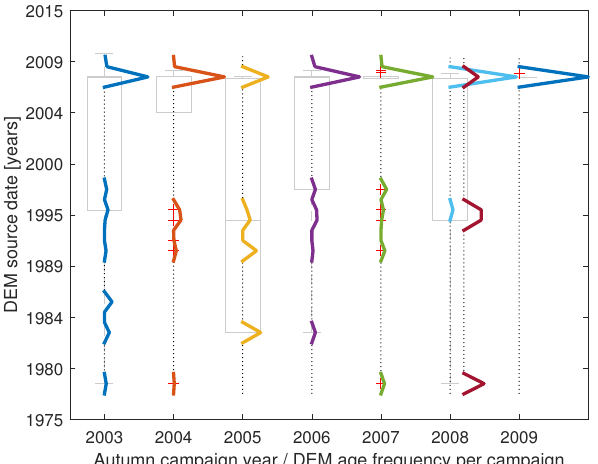
Figure 5. DEM source date distributions for ICESat autumn cam- paign samples on glaciers. The box plots emphasize the average DEM age per campaign while the frequency histograms (coloured curves) reflect the relative DEM age distributions. In 2008, the Oc- tober (blue) and December (brown) campaigns are shown separately (frequency histogram) and grouped (box